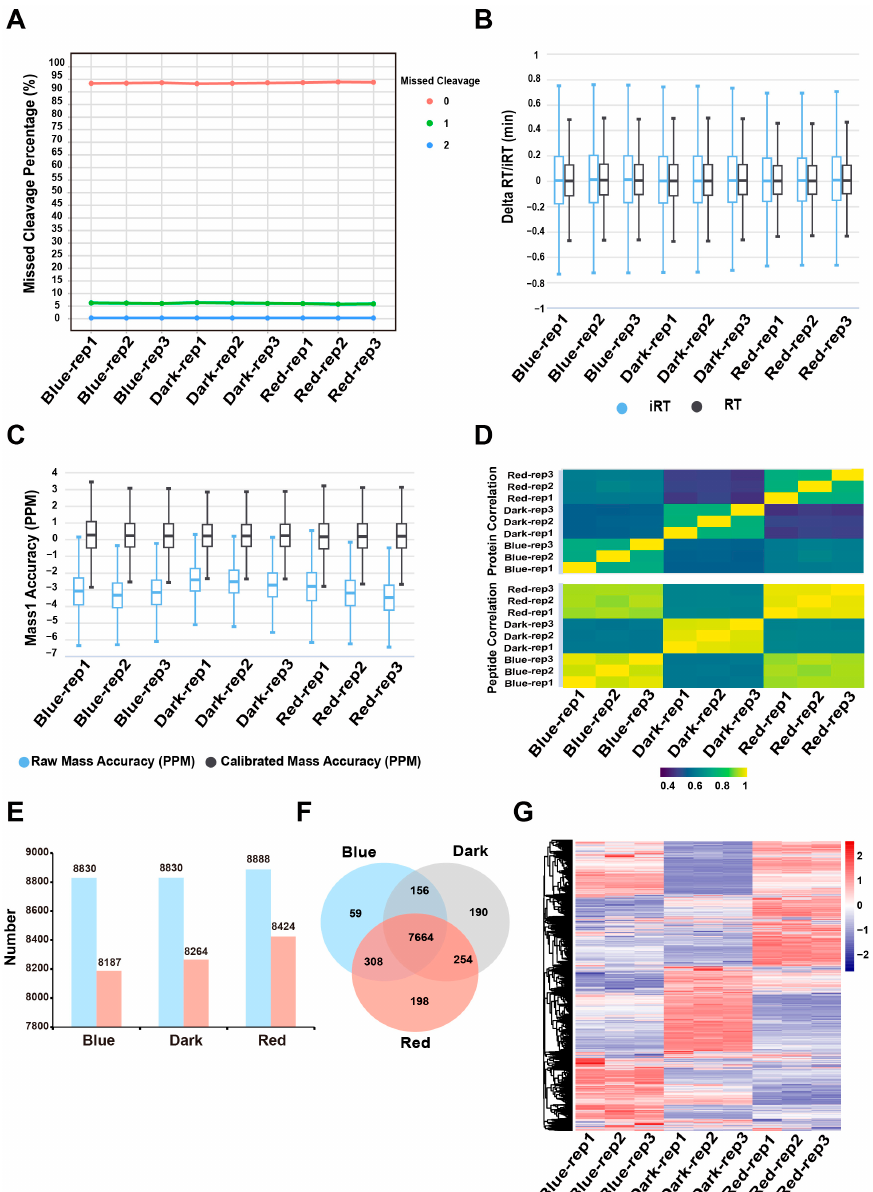
Figure 2. Quantitative proteomic analysis. ( A ) The percentage of peptides containing one (green dots), two (blue dots) or no missed cleavages (red dots) in each sample. The “rep” represents “replication”, the same as below. ( B ) The delta RT/iRT is the difference between a peptide theoretical and empirical RT/iRT, computed from the linear iRT/RT regression function [27]. ( C ) The plot of mass accuracy before and after calibration. These plots display the mass accuracy for all identified peptides at the precursor (MS1) level. The mass accuracy is calculated by dividing the (observed m / z -theoretical m / z ) by the theoretical m / z (in ppm). ( D ) The sample correlation matrix shows correlation of peptide/protein group quantities between all samples. ( E ) The numbers of identified proteins and quantified proteins in the moso bamboo samples under blue light, dark light and red light conditions. The blue bar represents the number of identified proteins. The red bar represents the number of quantified proteins (the proteins identified by all three replicates). ( F ) Venn diagram showing the specific quantified and shared quantified proteins of the moso bamboo seedlings under different light conditions. ( G ) Heat map of expression profiles for the shared quantified proteins in moso bamboo seedlings under different light